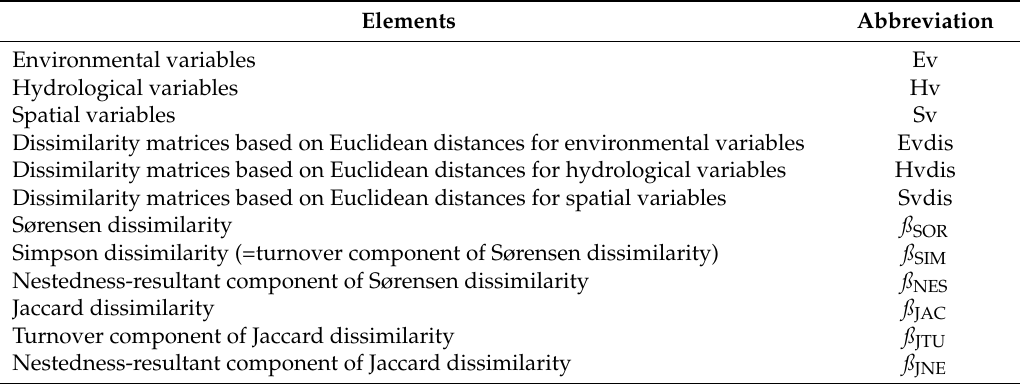
Table 1. Abbreviations used in this